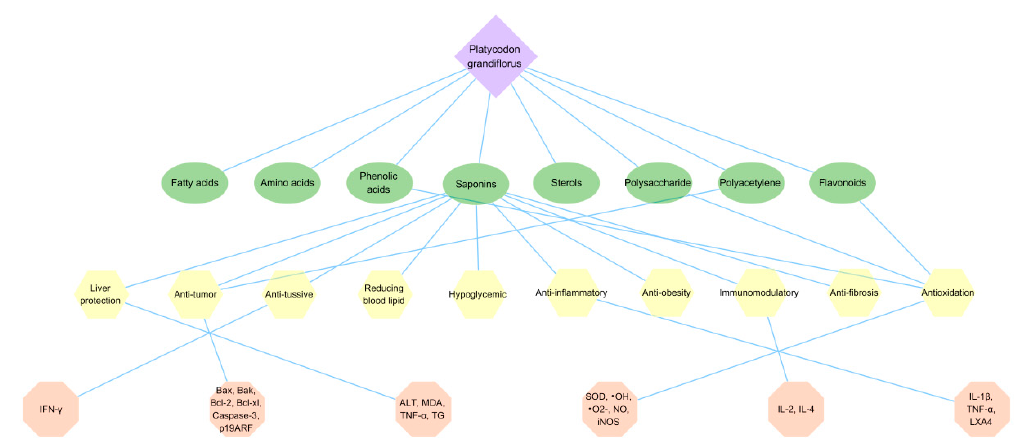
Figure 5. The pharmacological activity mechanism of P. grandiflorus . The green ovals represent some activity constituents, yellow polygons represent the common pharmacological activities of P. grandiflorus , while represented enzymes and signaling pathways are illustrated by pink polygons. Abbreviations here represent the same meaning as in the body text.